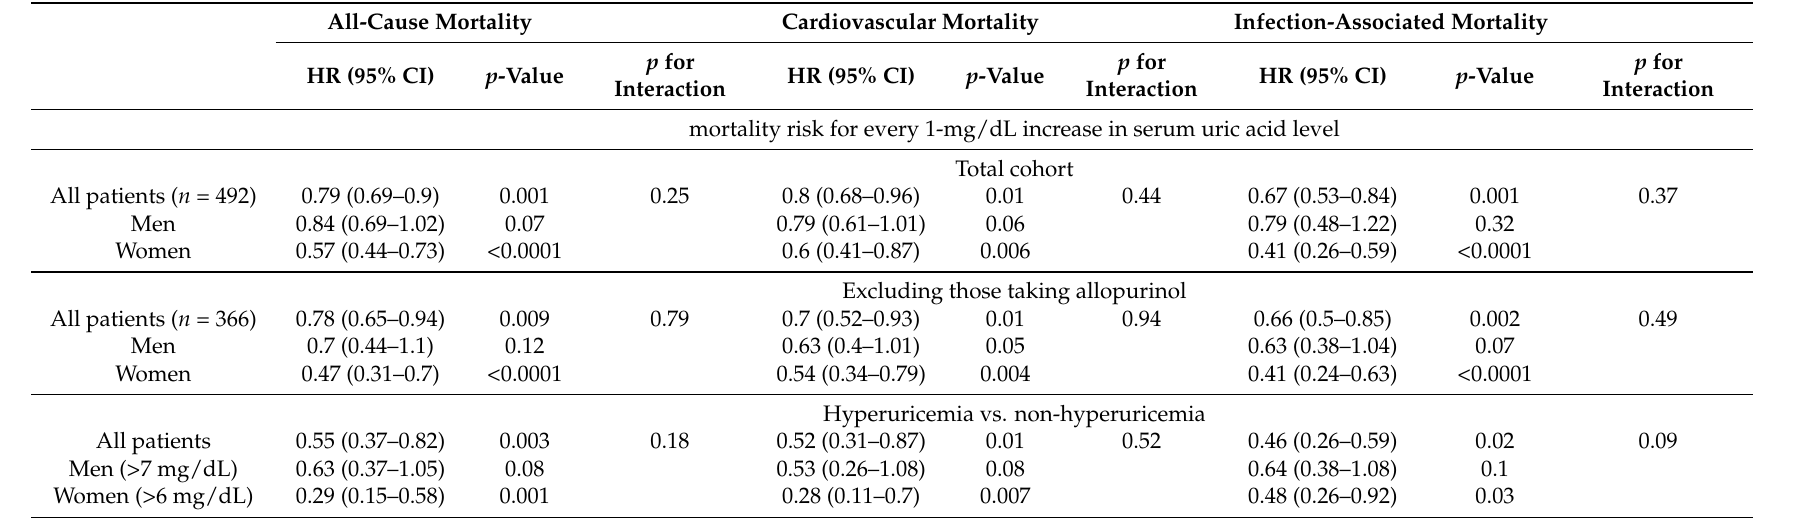
Table 4. Sensitivity analyses of mortality risk for uric acid a